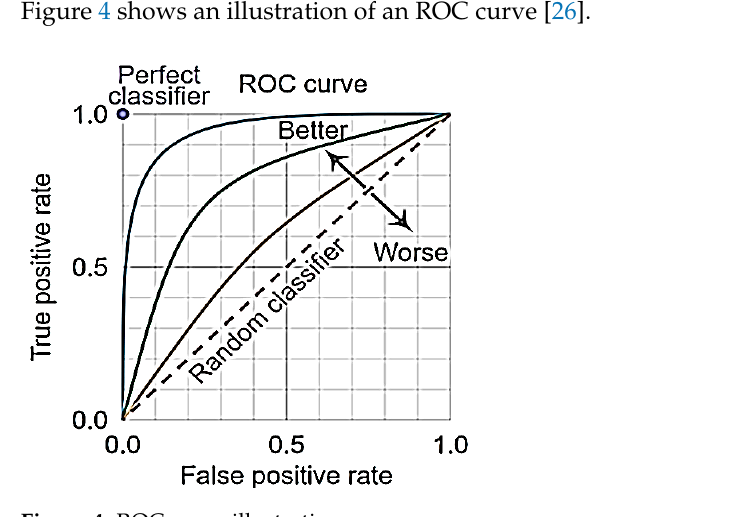
Figure 4. ROC curve illustration.